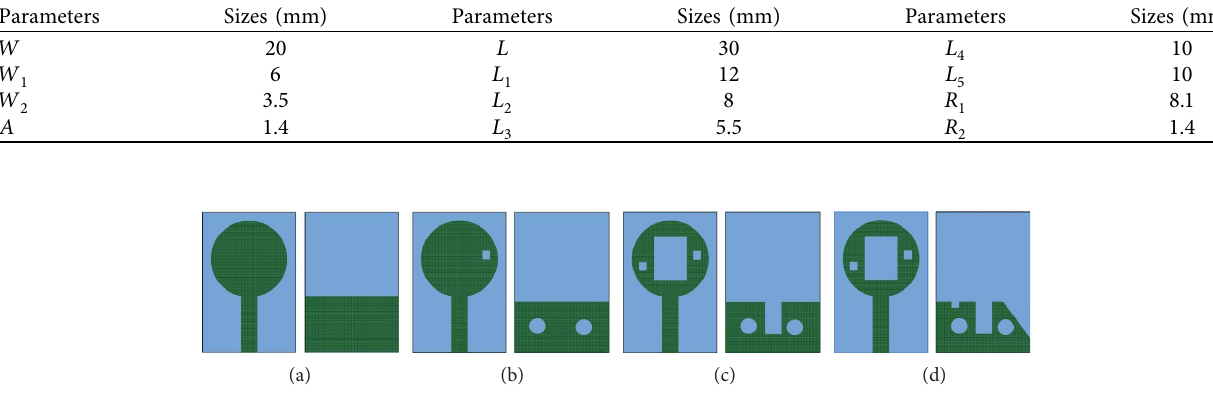
Figure 4: The design process of the UWB antenna. (a) Round monopole antenna. (b) Slotted circular antenna. (c) Microstrip antenna with rectangular slot. (d) Improved circular microstrip antenna with asymmetric defect ground.